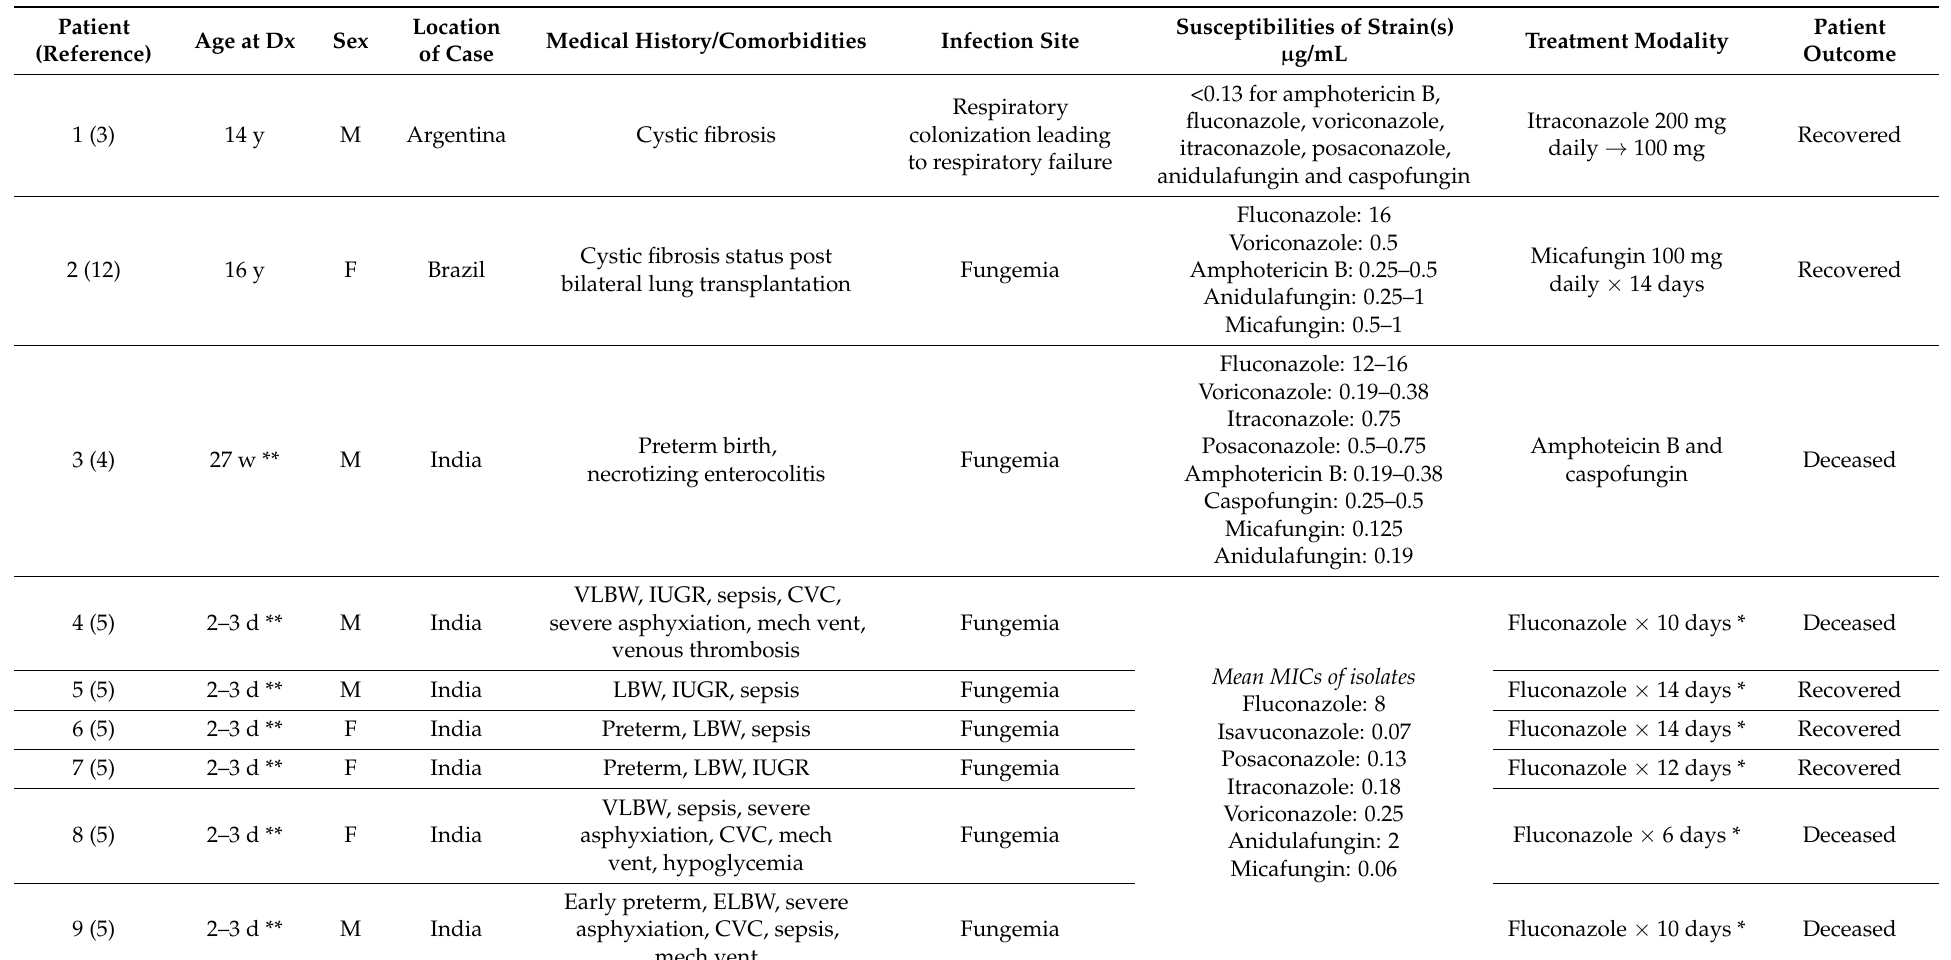
Table 1. Reported cases of C. blankii infection and